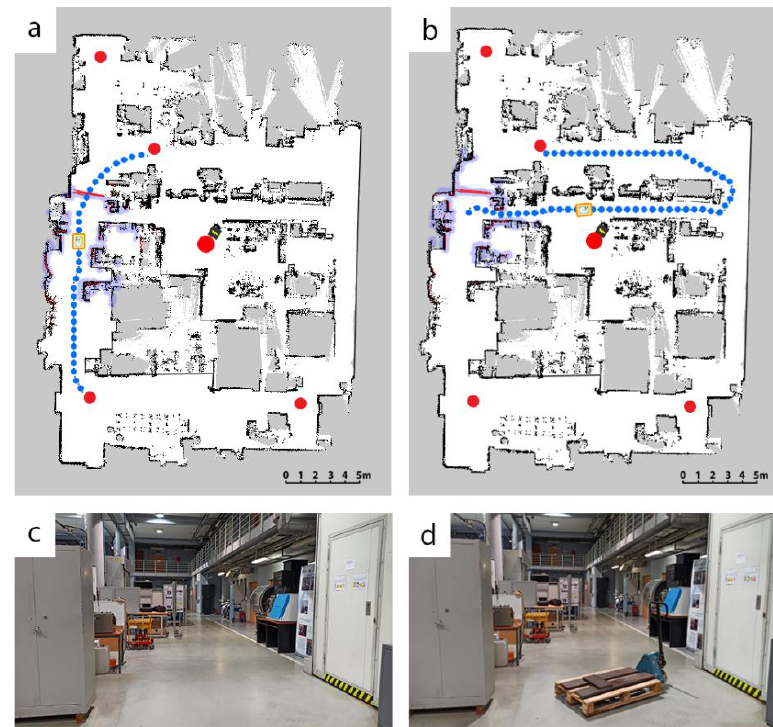
Figure 3. Dynamic detour planning upon detecting an obstacle: ( a ) map before detour, ( b ) planned detour upon detection of an obstacle, ( c ) unobstructed path, ( d ) obstructed path.